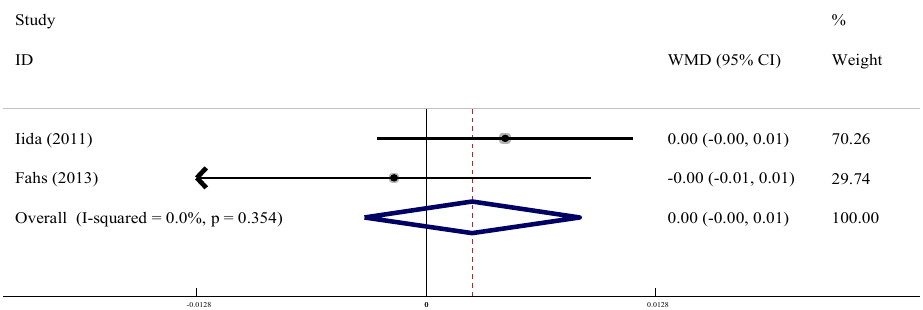
Figure 13. Meta-analysis of the effect of LL-BFR training on ABI of the older adults.